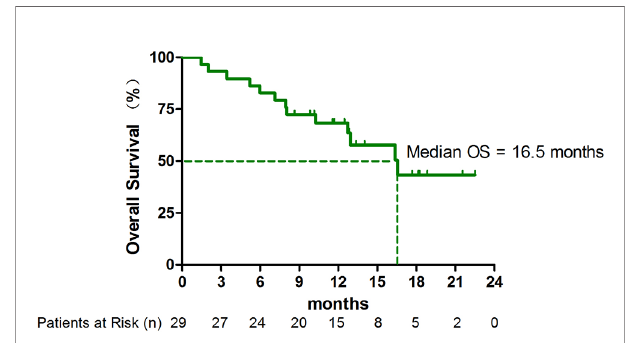
FIGURE 2 | Kaplan-Meier curve for overall survival (OS) (n